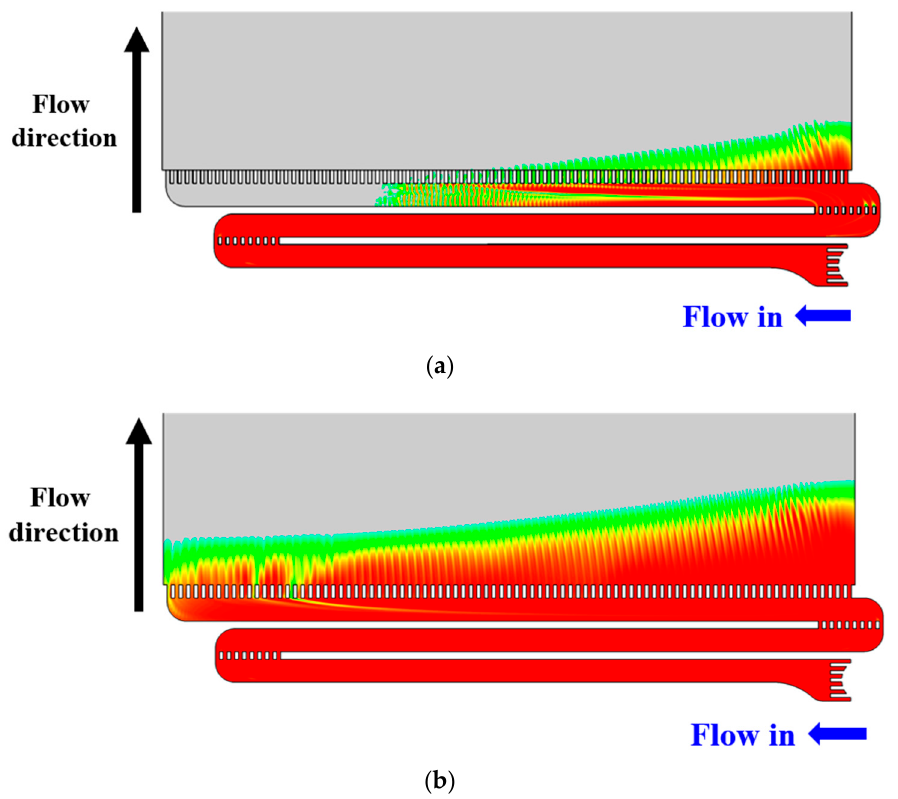
Figure 8. Volume fraction of vanadium solution (computational fluid dynamics (CFD) results). ( a ) Flow time t = 3 s; ( b ) Flow time t = 4 s.